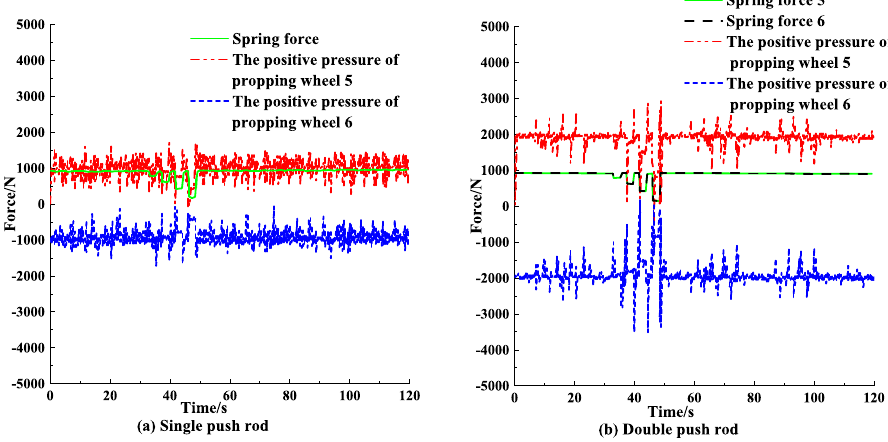
Figure 12. The change of positive pressure of single push rod support adjustment mechanism, double push rod − double spring support adjustment mechanism under the barrier of casing wear.